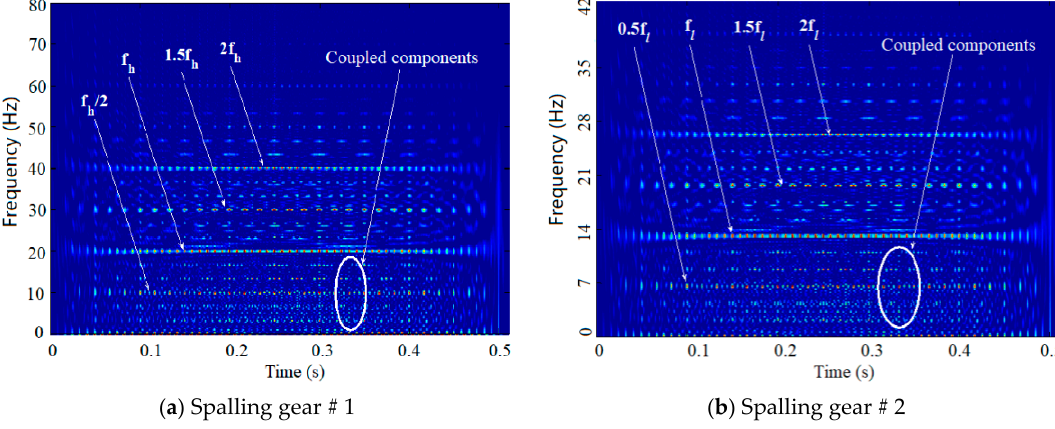
Figure 8. Two independent sources separated by nonlinear ICA with spalling gear #1 and spalling gear #2.